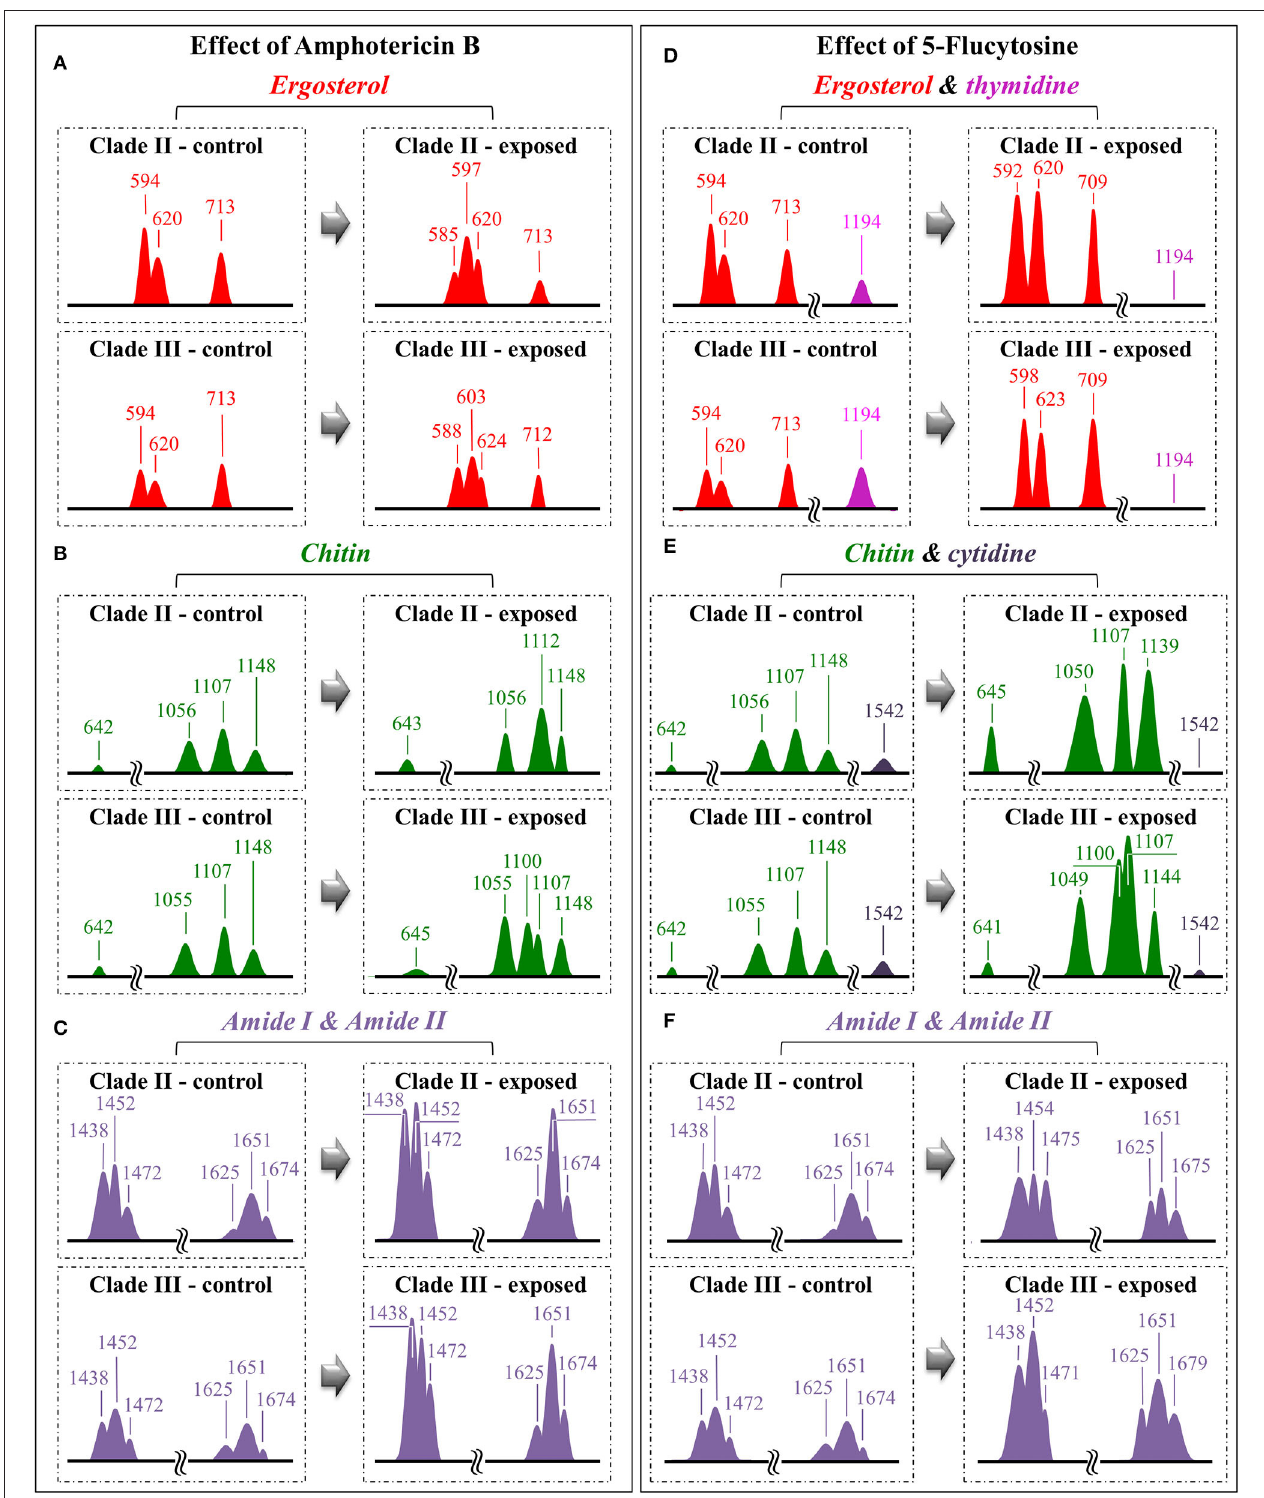
FIGURE 8 | Diagrams drawn to summarize the spectroscopic differences recorded between contro and drug-treated C. auris (cf. labels); the sub-band components discussed in the text as markers of specific molecules are redrawn and compared with respect to their normalized intensities and wavenumber positions: for the effects of Amphotericin B, Ergosterol (A) , Chitin (B) and Amide I & II (C) ; for the effect of 5-Flucytosine, Ergosterol & thymidine (D) , Chitin & cytidine (E) and Amide I & II (F) .